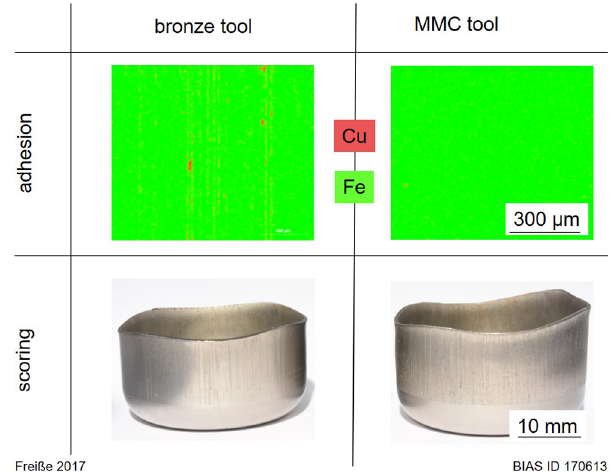
Fig. 22. Adhesive and abrasive wear in the deep drawn cups using bronze tool with and without